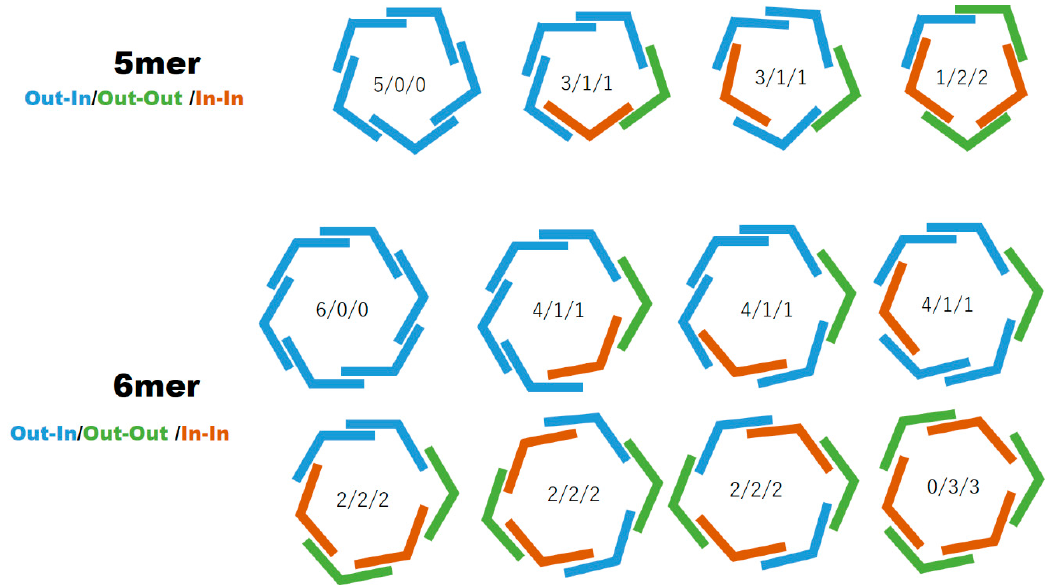
Figure 6. Possible coordination isomers (conformational isomers) of self-assembled pentamers and hexamers composed of Gable porphyrin (GP). Molecular models of a 5mer (Out-In/Out-Out/In-In = 5/0/0, clockwise) and a 6mer (6/0/0) are presented in Figure 4.